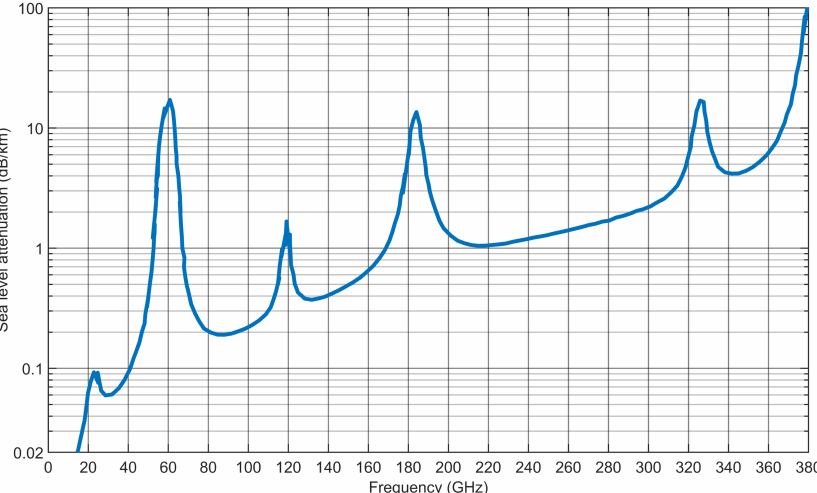
Figure 2. Average millimeter-wave atmospheric absorption at the frequency range 1–300 GHz